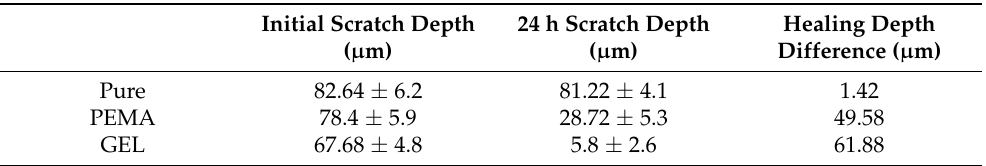
Table 4. Initial scratch depth, 24-h scratch depth and the healing depth differences for the pure epoxy primer, the PEMA microcapsule epoxy primer mix, and the GEL microcapsule epoxy primer mix.